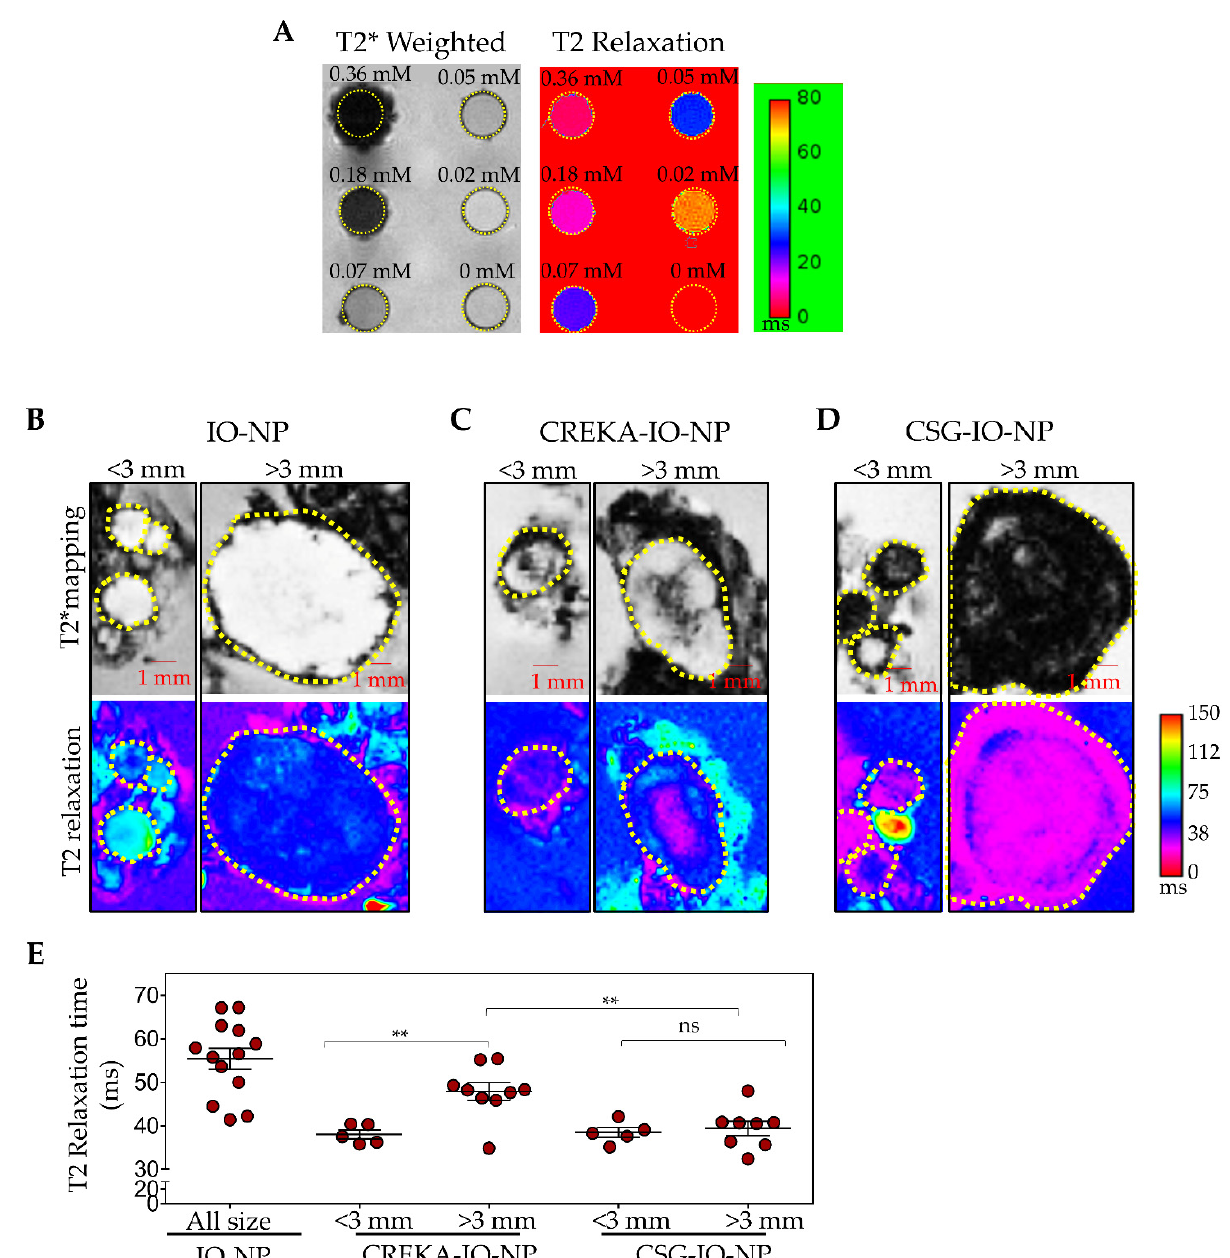
Figure 6. CSG-IO-NP show greater MRI tumour contrast compared to untargeted or CREKA-IO-NP. ( A ) T2*-weighted images (black and white) and T2 relaxation maps (coloured) of IO-NP at indicated concentrations ranging from 0 to 0.36 mM Fe. ( B , C , D ) Representative images of T2*-weighted (top) and T2 relaxation maps (magenta, bottom) of tumours with exocrine pancreas following ex vivo MRI scan. Tumours were analysed based on their sizes (<3 mm or >3mm in diameter). Scale bar: 1 mm. RIP1-Tag5 tumours and exocrine tissue were isolated after 4 h of in vivo circulation of untargeted-IO-NP, CREKA-IO-NP and CSG-IO-NP in tumour-bearing mice ( n = 10–15 tumours from n = 5–6 mice per group, 5 mg/kg Fe). Mice were perfused with PBS to remove the unbound particles. The MRI scan was performed on formalin-fixed tumours embedded in 2% agarose. ( E ) Reduction in T2 relaxation time indicates the relative increase of IONP in individual tumours and mean ± SEM (** p < 0.01 by Student’s t -test. n.s. = not